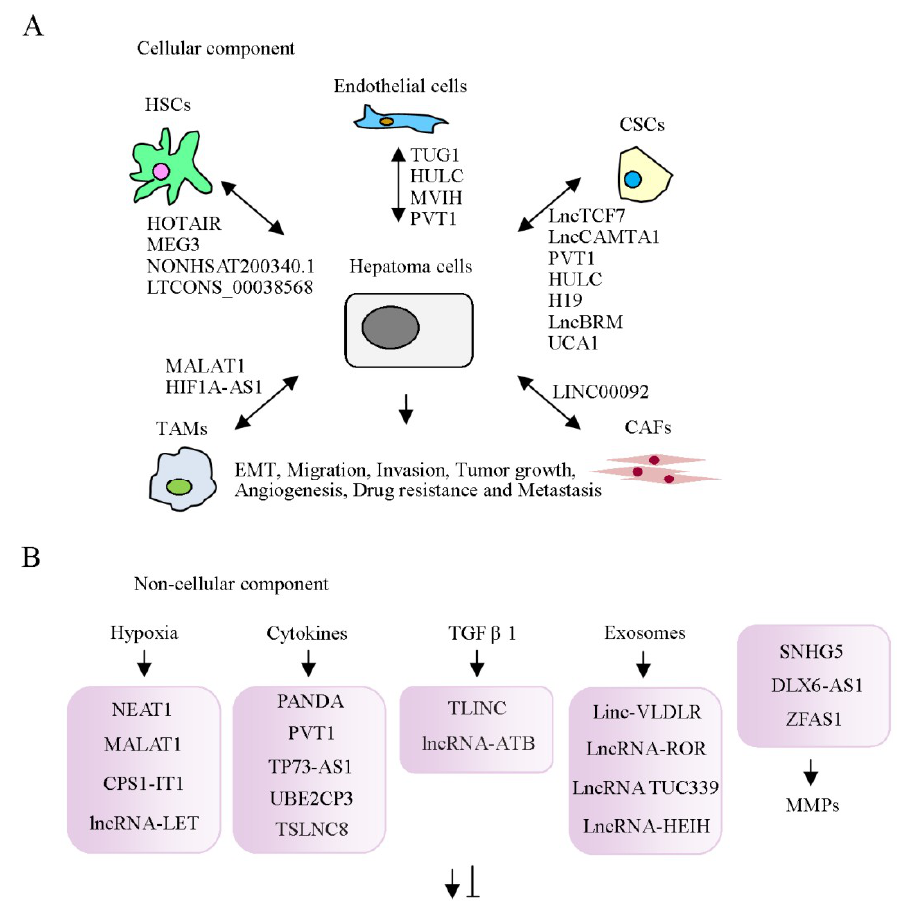
Figure 2. Schematic depiction of significant lncRNAs involved in interactions of hepatoma cells with tumor microenvironment components. ( A ) Cellular components: cancer-associated fibroblasts (CAF), hepatic stellate cells (HSC), tumor-associated macrophages (TAM), endothelial cells and cancer stem cells (CSC) cross-talk with hepatoma cells via multiple lncRNAs, as indicated. ( B ) Non-cellular components: reciprocal regulation of hypoxia, cytokines, TGF- β 1, exosomes, matrix metalloproteinases (MMPs), and lncRNAs.